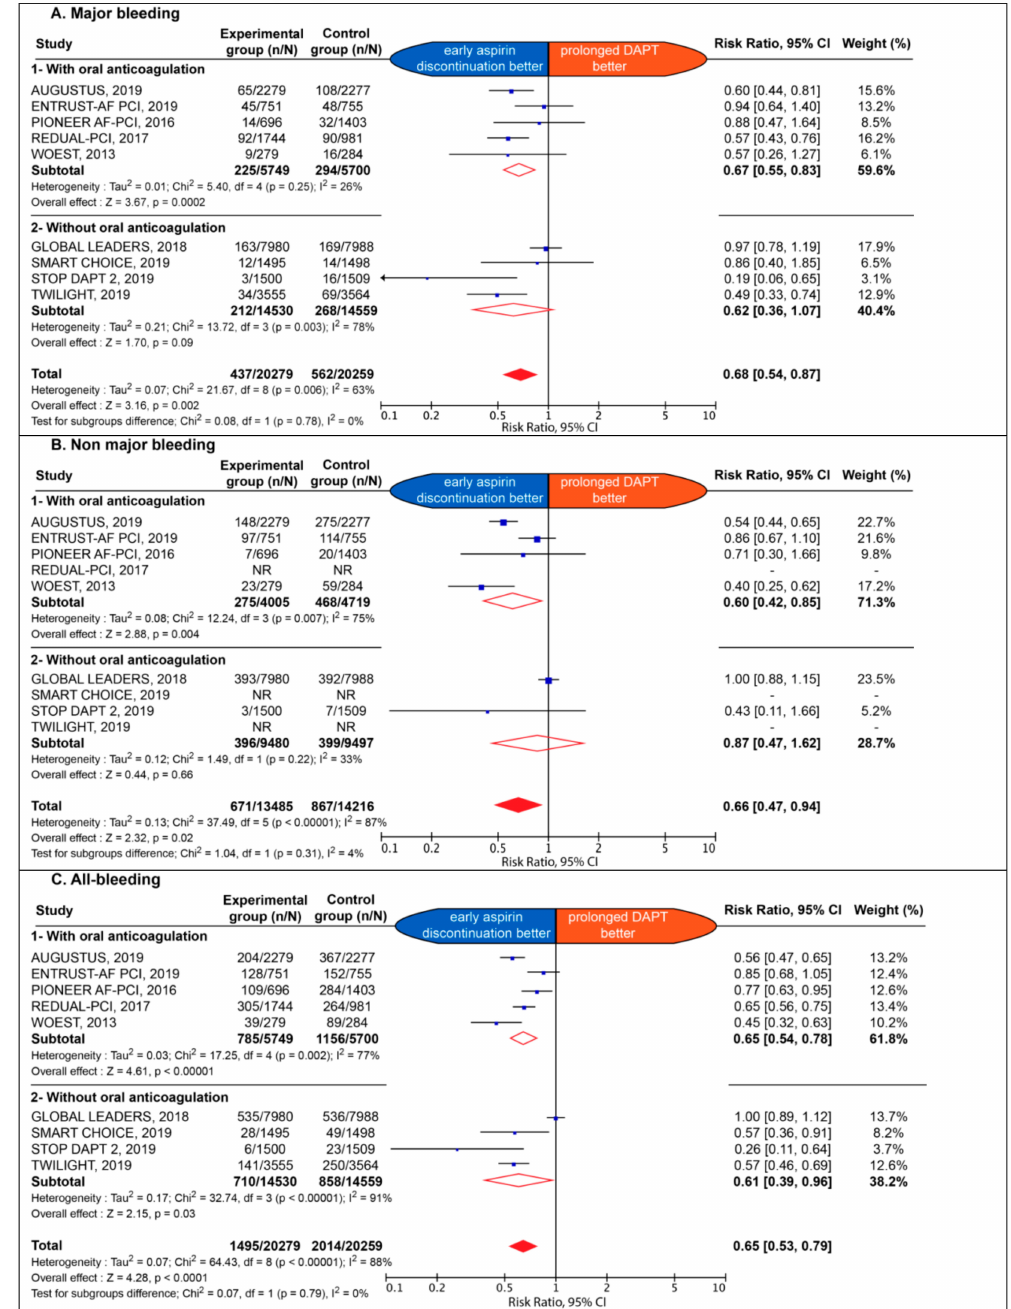
Figure1. Estimateriskofmajorbleeding( A ),non-majorbleeding( B ),andallbleeding( C ).CI:confidence interval; DAPT: dual antiplatelet therapy; NR: not